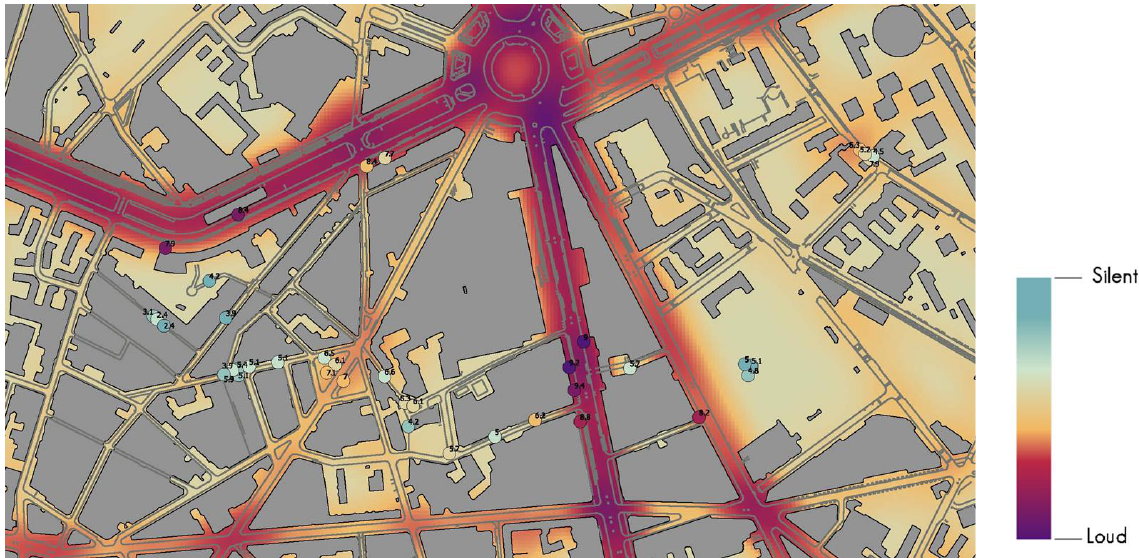
Figure 16: Mapping of loudness represented only on open spaces (Eq. 5).The circles represent the mean values of perceived loudness evalu- ated by